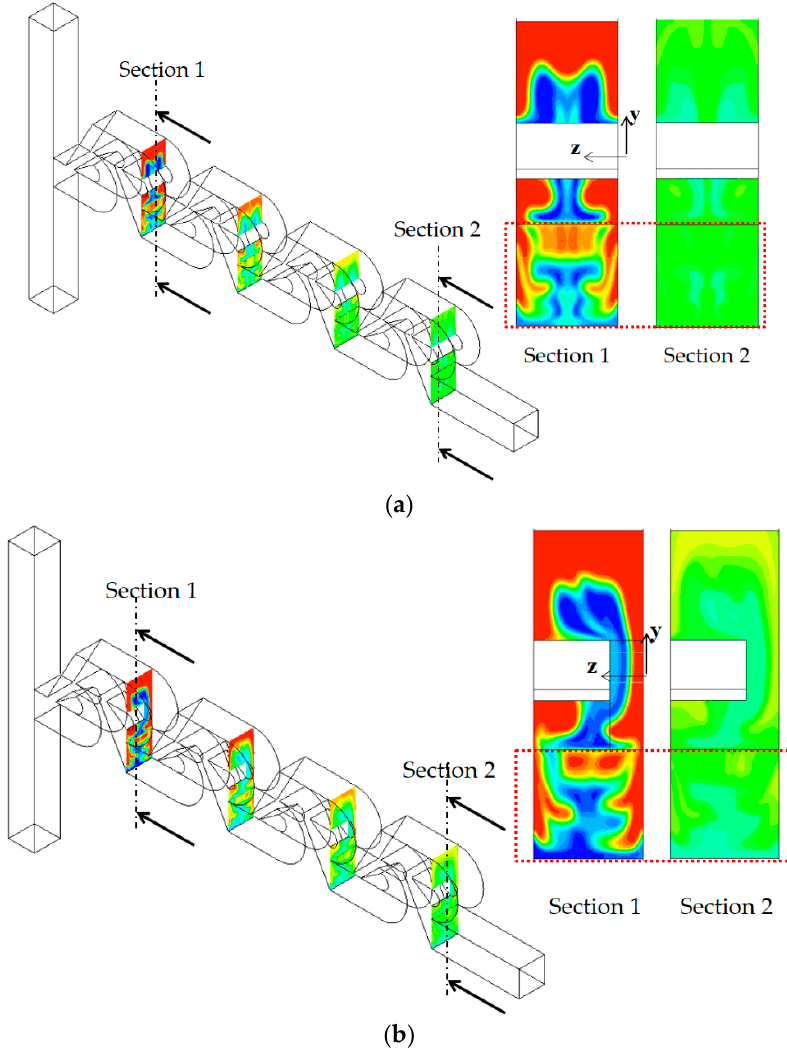
Figure 19. Evolution of mixing on the yz planes for Re = 50: ( a ) no tip clearance and ( b ) tip clearance h = 60 μ m. h = 60 µ